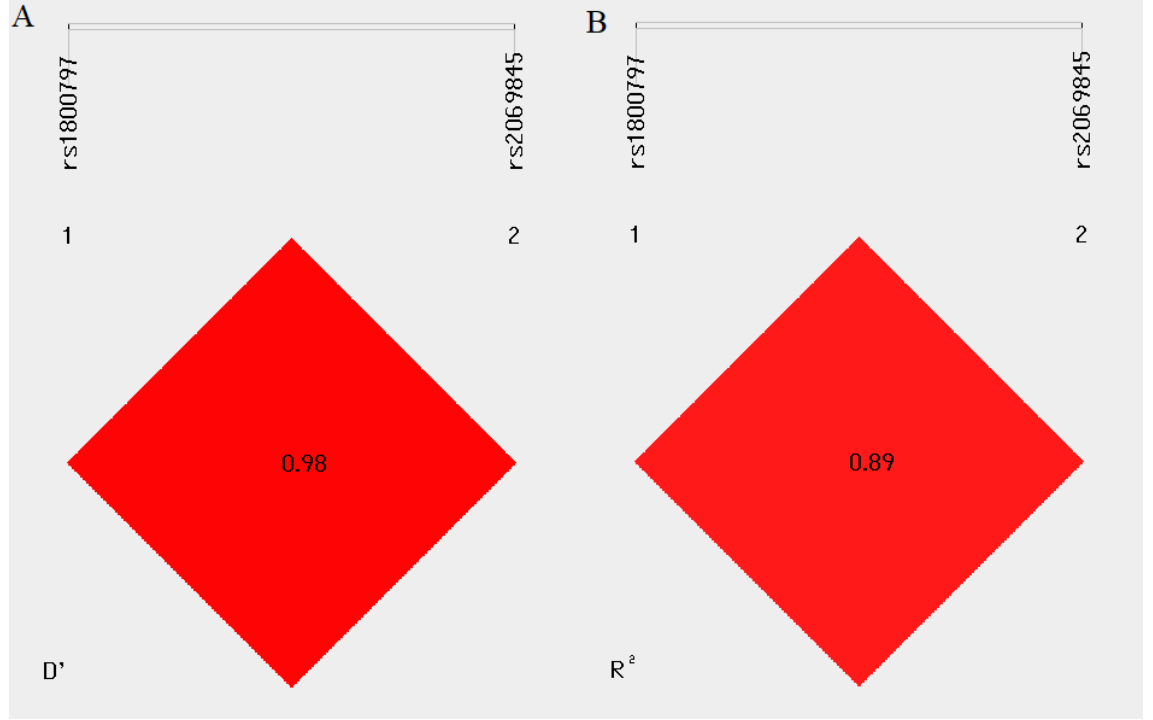
Figure 1. Analysis of linkage disequilibrium of the rs2069845 and rs1800797 polymorphisms in the IL-6 gene. Pairwise D’ values ( A ). Pairwise R 2 values ( B ). R 2 ≥ 0.8—high LD.